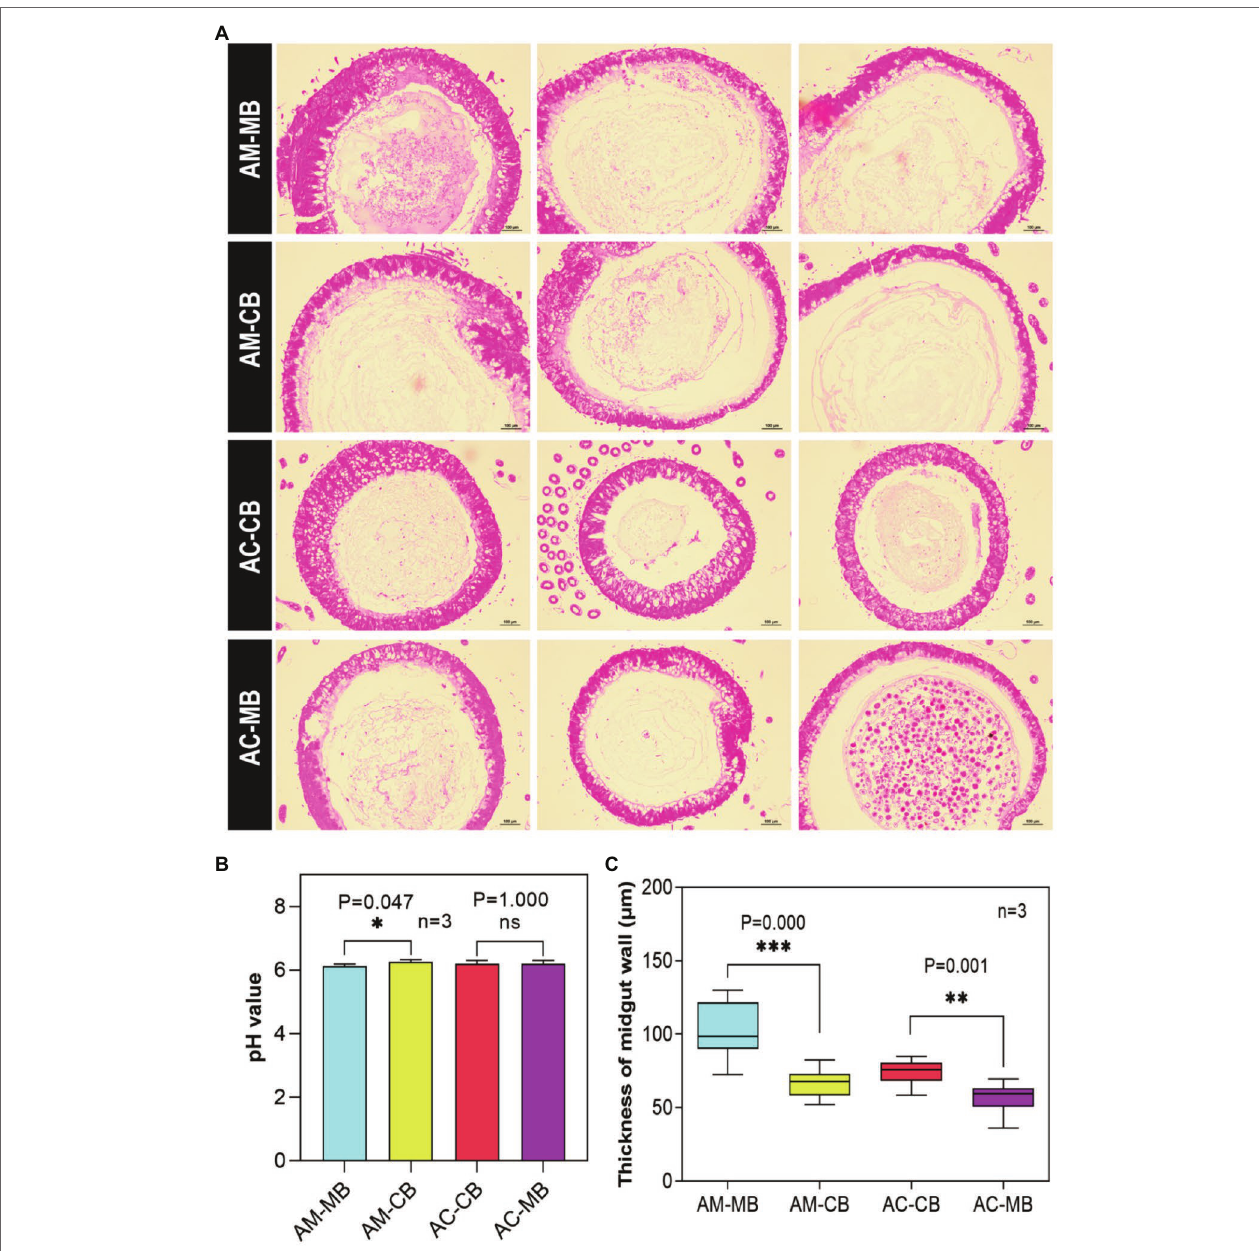
FIGURE 4 | Effect of dietary habit changes on midgut development of 9-day-old Apis mellifera and Apis cerana workers under different treatments. (A) Cross section of the midgut of workers aged 9 days old (H&E, 100×). (B) pH values in midguts of workers aged 9 days old under different treatments. (C) Effects of dietary habit changes on midgut thickness of workers aged 9 days old under different treatments. Values are means ± SME. * p < 0.05, ** p < 0.01, and *** p < 0.001 by independent samples t